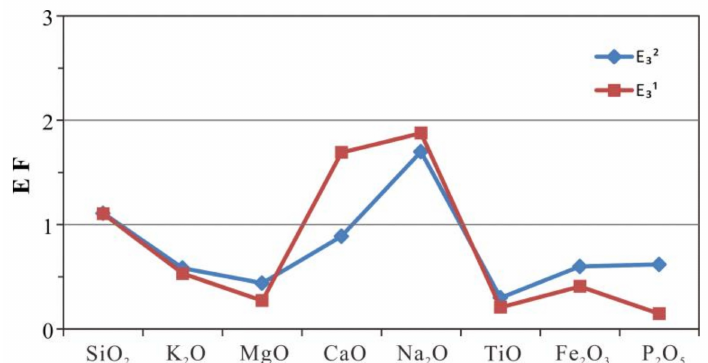
Figure 5. Comparison of major oxides measured in samples and those of the average shale [40]. (EF (enrichment factor) = Csediment / Cstandard rock). E 32 = Upper Xiaganchaigou Formation. E 31 = Lower Xiaganchaigou Formation.